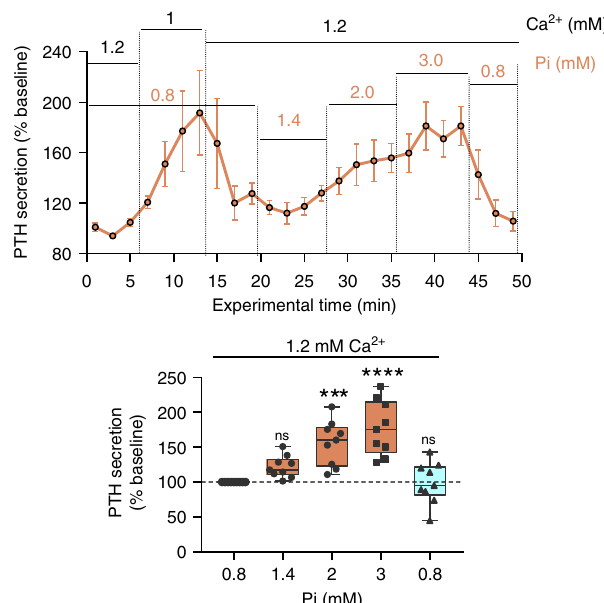
Fig. 3 Pathophysiologic Pi concentrations increase PTH secretion in human parathyroid cells. Effect of hyperphosphatemia on PTH secretion (measured every 2min) from perifused, freshly isolated human parathyroid cells (upper).